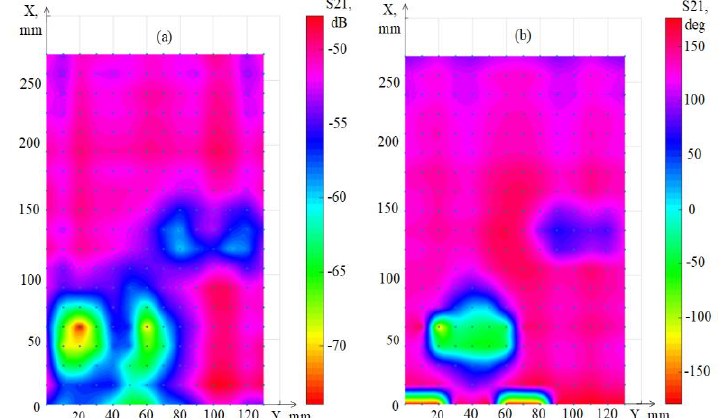
Fig. 8. Measurement results of the amplitude (a) and phase (b) of the transmission coefficient with a 1200 MHz signal.